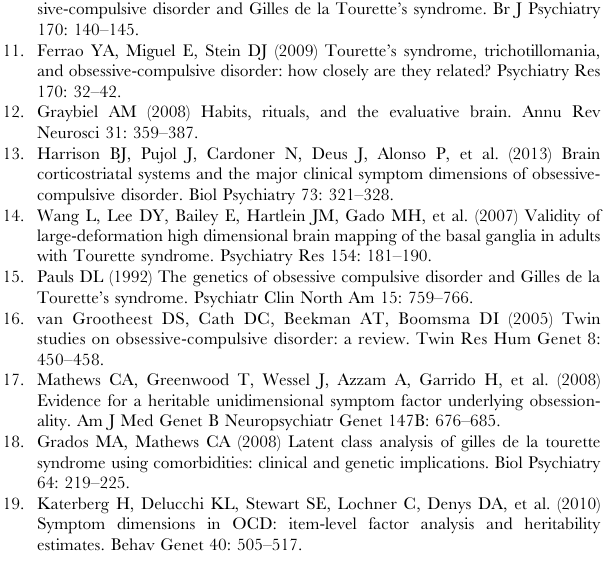
Table S3 Heritability for Tourette syndrome, obsessive-com- pulsive disorder, and early onset obsessive-compulsive disorder at a range of reported population prevalence rates. Table S4 Heritability in terms of sibling recurrence risk ( l ) for Tourette syndrome, obsessive-compulsive disorder, and early onset obsessive-compulsive disorder at a range of population prevalenc- es. The title l 1st-GCTA refers to the risk to first degree relatives calculated from the given population prevalence and GCTA based heritability estimate. The title l 1st-lit refers to the risk to first degree relatives calculated from the given population prevalence and the heritability estimates from the literature cited in the main text of the paper. Table S5 Tourette Syndrome heritability partitioned by chro- mosome. Heritability estimates given for each chromosome for both directly genotyped and imputed data. P-values calculated with a likelihood ratio test are also included; * indicates p-values significant after Bonferroni correction. Table S6 Obsessive-compulsive disorder heritability partitioned by chromosome. Heritability estimates given for each chromo- some for both directly genotyped and imputed data. P-values calculated with a likelihood ratio test are also included; * indicates p-values significant after Bonferroni correction. Table S7 GWAS estimated heritability partitioned by genic regions. Heritability estimates for TS and OCD partitioned based on genic annotation. ‘‘Genic’’ includes all coding, intronic, 3 9 UTR and 5 9 UTR SNPs. Intergenic is defined as not otherwise genic. The number of SNPs (proportion of total SNPs), heritability, and proportion of total heritability is given for TS and OCD. Table S8 Partitioning analysis of heritability based on brain eQTL annotations. Partitions include eQTLs identified in cerebellum only, in parietal cortex only, in both parietal cortex and cerebellum, and non-eQTL SNPs.